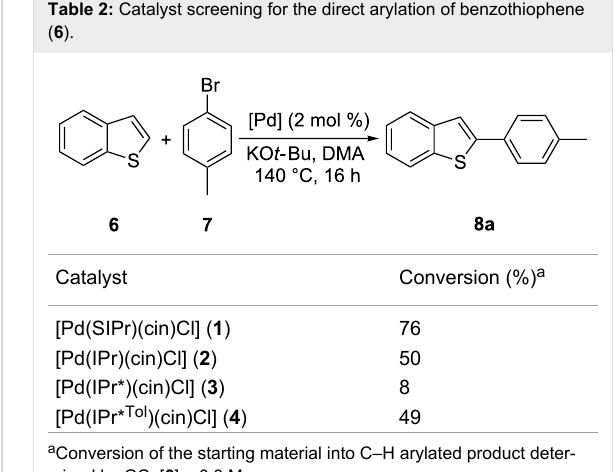
Table 2: Catalyst screening for the direct arylation of benzothiophene ( 6 ).